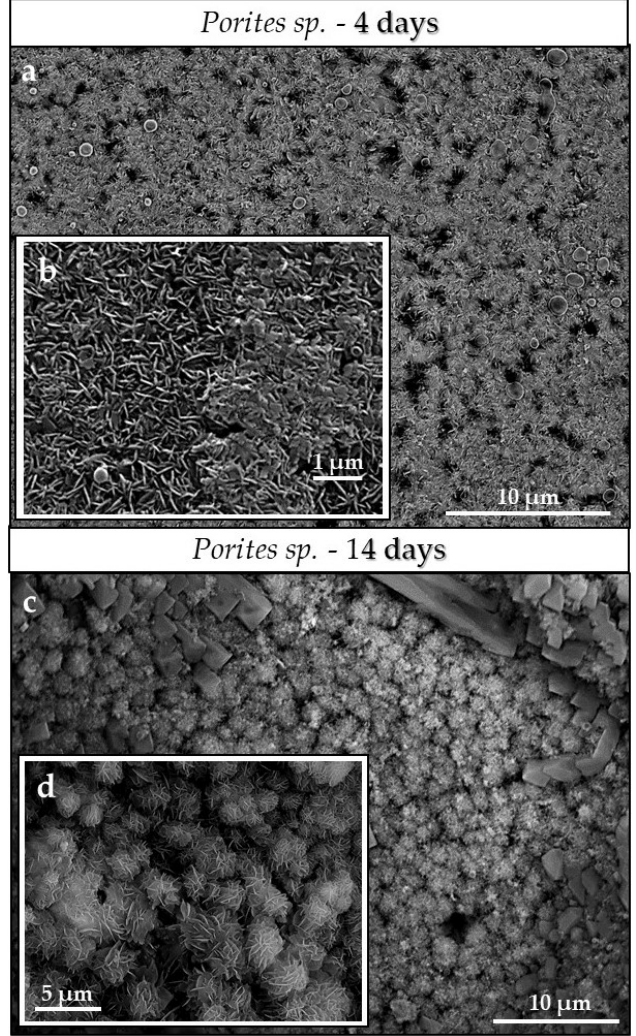
Figure 5. FE-SEM images depicting the coral skeleton Porites sp. after ( a ) 4 and ( b ) 14 days of conversion. Newly formed AP crystals cover the surface of the hard tissue already at 4 days of conversion. The compactness of the AP cover increases significantly with conversion time. SEM images shown in ( b , d ) depict AP crystal morphologies that form with different conversion times.